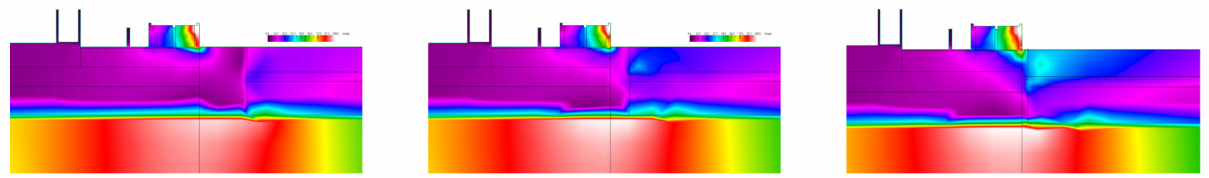
Figure 11. PVC frame, Thermal Break 50 mm, 20 mm, 0.6 mm heat transfer analysis w/m 2 .